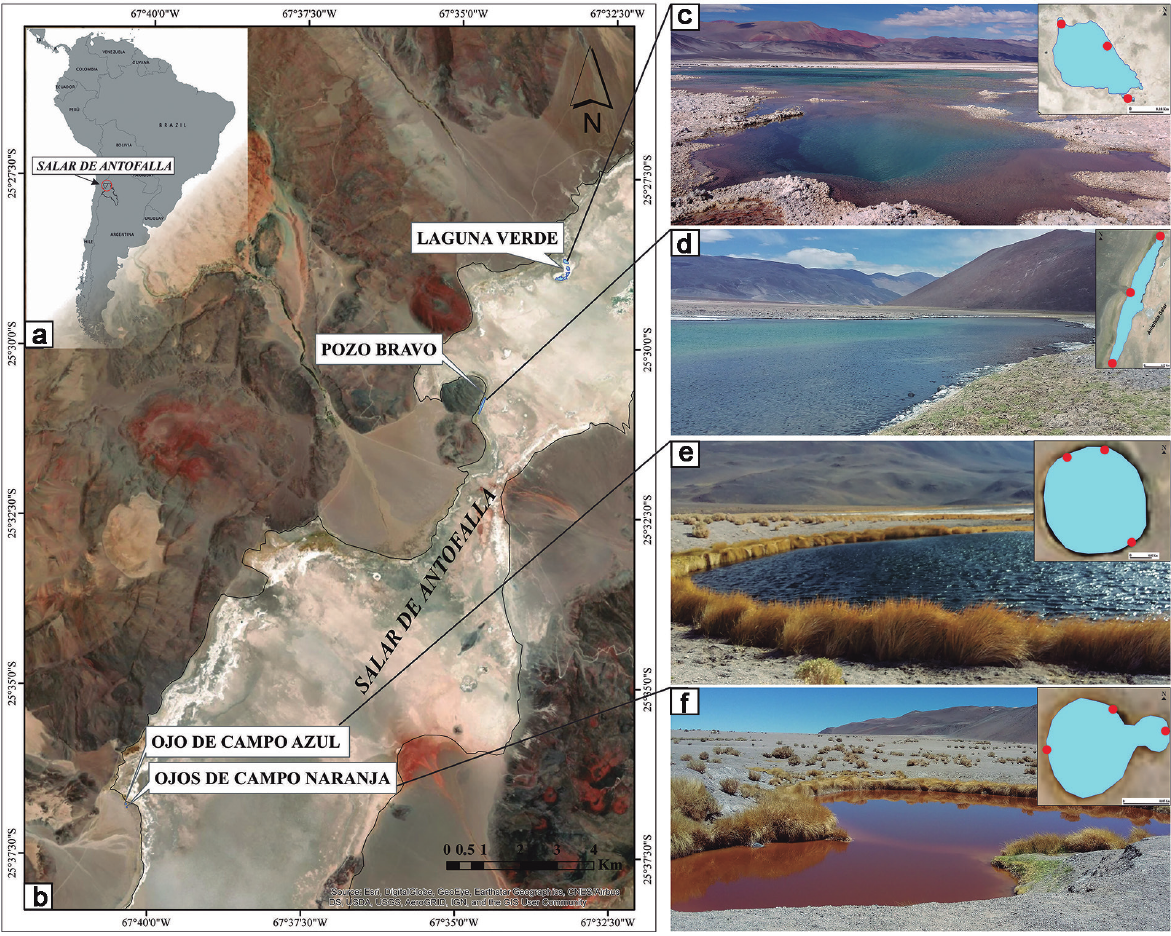
Figure 1. Geographical location of the study area. ( a ) Location of the Salar de Antofalla in the Catamarca province, Argentina, South America. ( b ) Location of the four wetlands in the Salar de Antofalla. ( c ) Laguna Verde (LV). ( d ) Pozo Bravo (PB). ( e ) Ojo de Campo Azul (OCA). ( f ) Ojos de Campo Naranja (OCN). Sampling sites at each wetland are marked with dots in Fig. 1c, d, e and